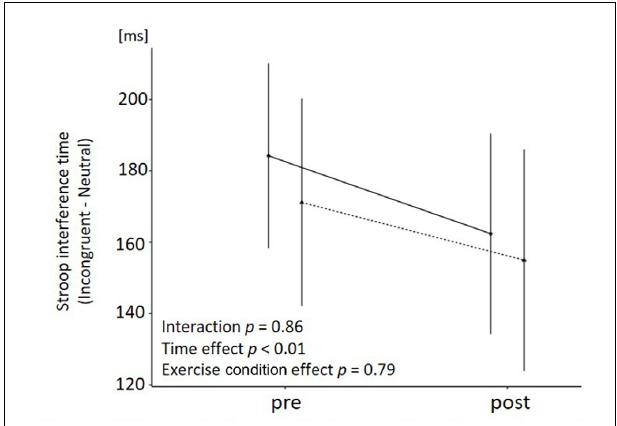
FIGURE 4 | Change in Stroop interference time for each condition. Mean and standard deviation are shown. The p value shows the results of the two-way ANOVA with time and exercise condition as